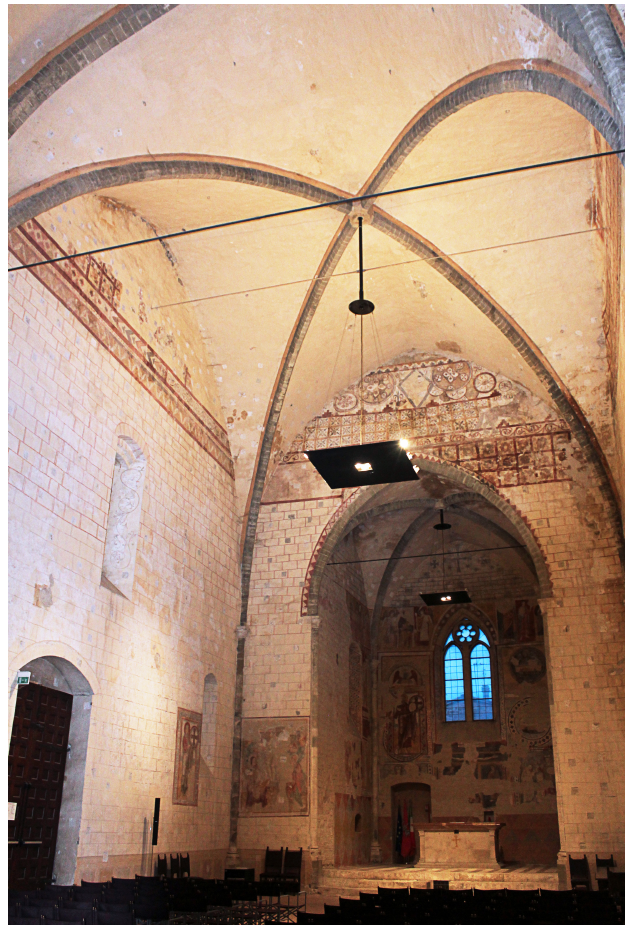
Figure 3. View of the interior of the church of San Bevignate (see cone of vision 1 in Figure 2).